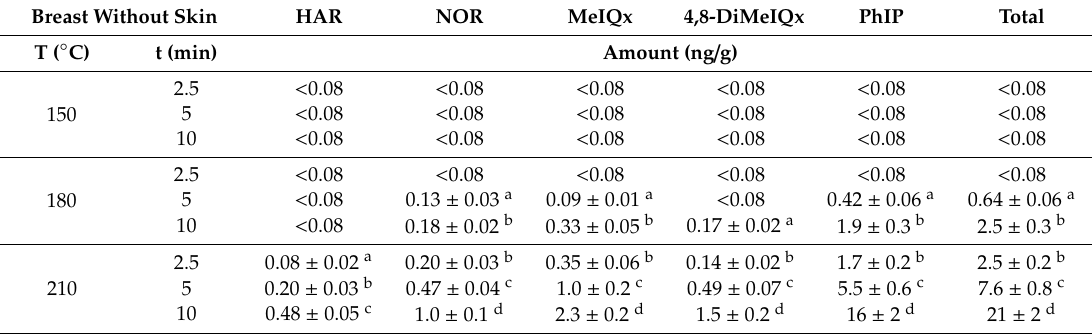
Table 2. Heterocyclic amine (HCA) content of heat-treated chicken breast without skin. Breast Without Skin HAR NOR MeIQx